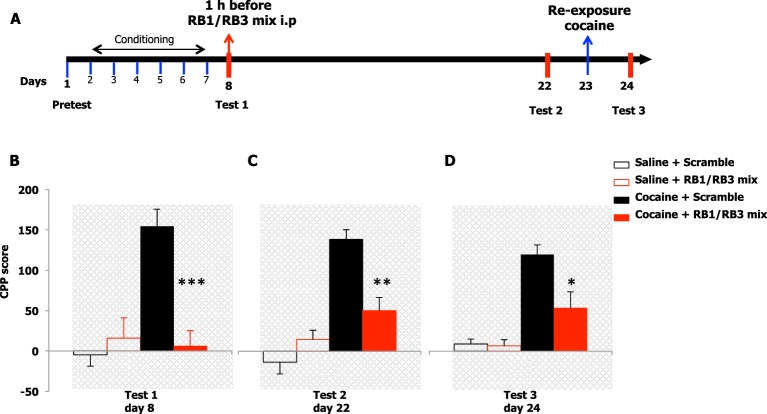
Retrieval of cocaine place preference is partially inhibited by RB1 and RB3 peptides.(A) Experimental design of experiments reported in B, C and D. (B) The rewarding properties of cocaine (20 mg/kg, i.p.) were first measured on day 8 (test 1). Mice treated with cocaine or saline during conditioning were further divided in 2 groups and received an acute injection of the RB1/RB3 mix (20 mg/kg, i.p.) or scrambled mix (20 mg/kg, i.p.) 1 hr prior to testing. RB1/RB3-treated mice showed a reduction in CPP relative to scrambled control subjects. A two-way ANOVA revealed a significant effect of drug F1,36 = 12.518, p<0.01, peptides F1,36 = 9.152, p<0.01 and interaction between these two factors F1,36 = 16.106, p<0.001; Bonferroni’s post-hoc, cocaine scrambled mix (n=12) vs cocaine RB1/RB3 mix (n=12), p<0.0001; cocaine RB1/RB3 mix (n=12) vs saline RB1/RB3 mix (n=8), p>0.05; cocaine scrambled mix (n=12) vs saline scramble mix (n=8), p<0.0001. (C) Two weeks later (test 2, day 22), mice were then re-tested in the place conditioning apparatus in a drug-free state. Mice that previously received the RB1/RB3 combination spent significantly less time than controls in the drug-paired compartment. A two-way ANOVA revealed a significant effect of drug F1,36 = 41.186, p<0.001, peptides F1,36 = 4.327, p<0.05 and interaction between these two factors F1,36 =15.912, p<0.01; Bonferroni’s post-hoc, cocaine RB1/RB3 mix (n=12) vs cocaine scramble mix (n=12), p<0.01; cocaine RB1/RB3 mix (n=12) vs saline RB1/RB3 mix (n=8), p>0.05; cocaine scramble mix (n=12) vs saline scramble mix (n=8), p<0.0001. (D) One day 23, all groups underwent a cocaine (20 mg/kg, i.p.) re-exposure in the drug-paired compartment. Twenty-four hours later (test 3, day 24), animals were retested for preference in a drug- and peptide-free state. CPP was still partially inhibited in RB1/RB3 pre-treated mice. A two-way ANOVA revealed a significant effect of drug F1,36 = 54.408, p<0.001, peptides F1,36 = 10.361, p<0.05 and interaction between these two factors F1,36 =8.857, p<0.01; post-hoc Bonferroni, cocaine RB1/RB3 mix (n=12) vs cocaine scramble mix (n=12), p<0.05; cocaine RB1/RB3 mix (n=12) vs saline RB1/RB3 mix (n=8), p<0.05; cocaine RB1/RB3 mix (n=12) vs saline scramble mix (n=8), p<0.05; cocaine scramble mix peptides (n=12) vs saline scramble mix (n=8), p<0.0001. *p<0.05, **p<0.01, ***p<0.0001. Data are shown as mean with SEM.